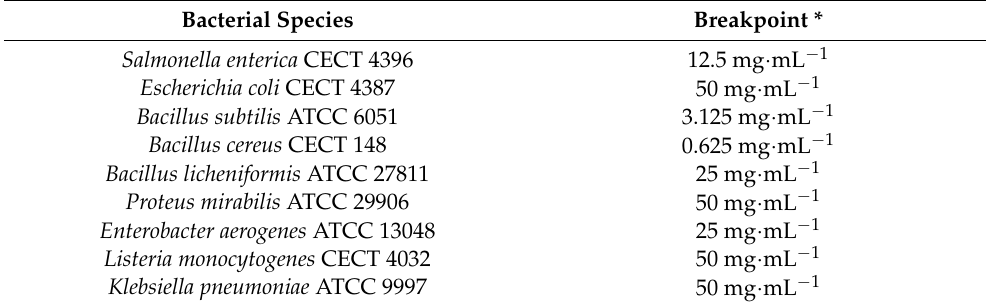
Table 3. Minimum inhibitory concentration of Gelidium flour extract on selected